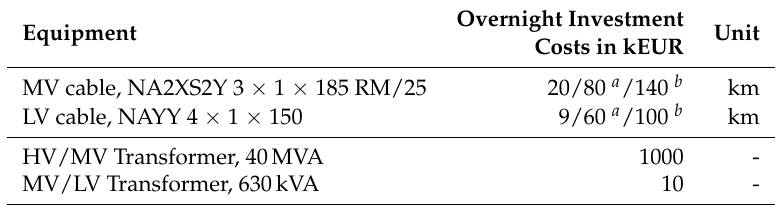
Table 2. Standard equipment for grid expansion in MV and LV grids [3]. a costs include earthwork costs in area with population density of ≤ 500 people/km 2 . b costs include earthwork costs in area with population density of > 500 people/km 2